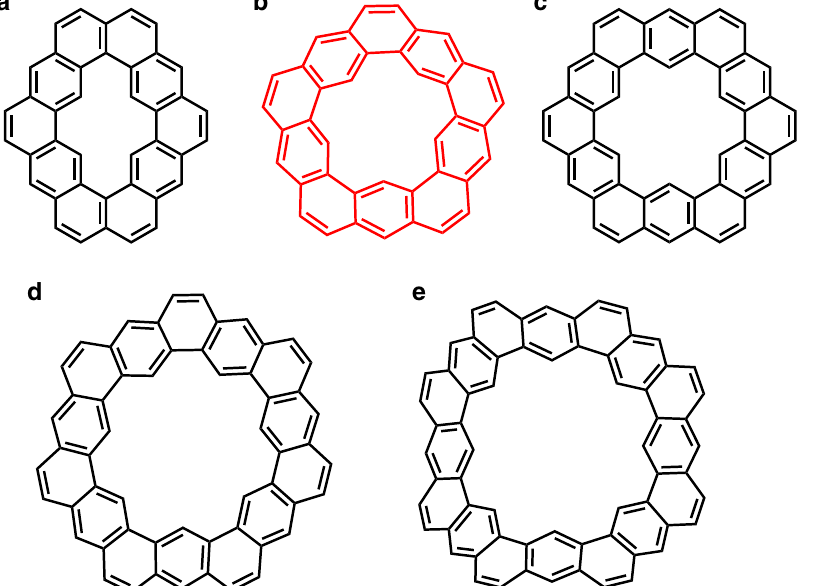
Fig. 1 Structure of synthesized cycloarenes. a cyclo[ d,e,d,e,e,d,e,d,e,e ]decakisbenzene, b quintulene, c Kekulene, d septulene, and e octulene. Quintulene was synthesized as its extended homolog in this